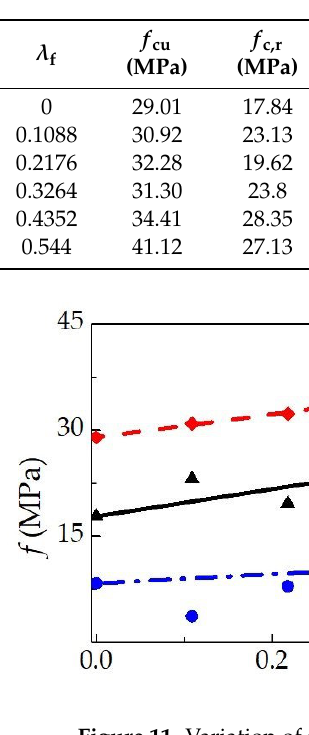
Figure 11. Variation of f cu , f c,r and ε c,r with a varying λ f .